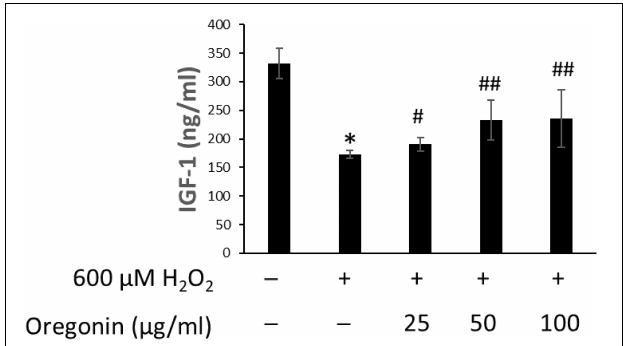
FIGURE 7 | Increasing effect of oregonin on IGF-1 formation. The cells were pre-incubated with the indicated dose of oregonin and treated with H 2 O 2 . The IGF-1 content (ng/ml) in the cell lysates was measured as described in the manufacturer’s instruction. Data were expressed as mean ± SD. * P < 0.01 vs normal group. # P < 0.05 and ## P < 0.01 vs H 2 O 2 -treated group. +, present; –, absent.